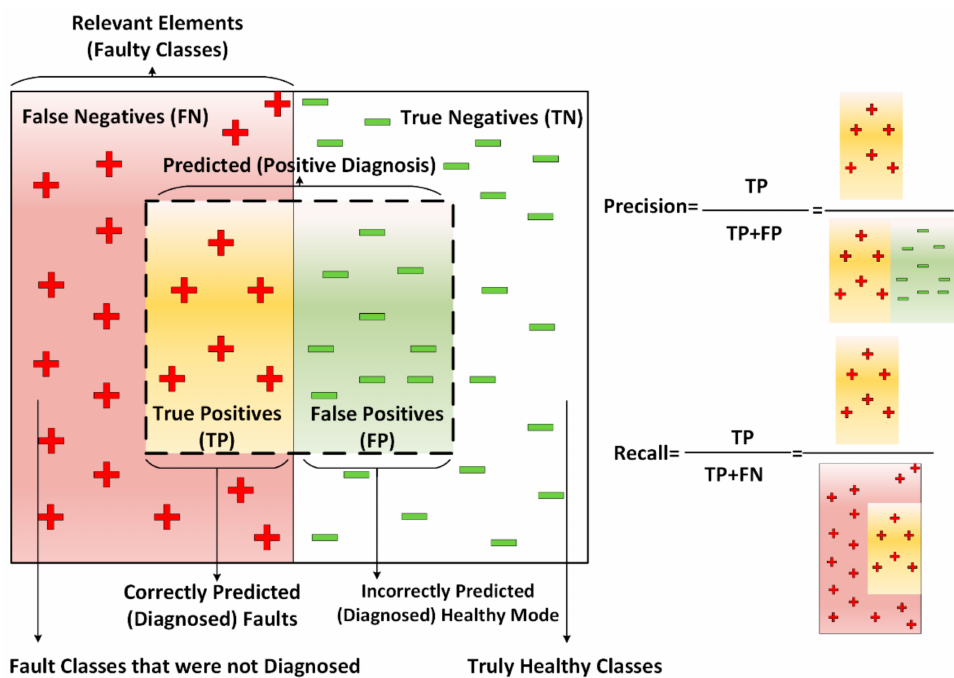
Figure 18. Performance